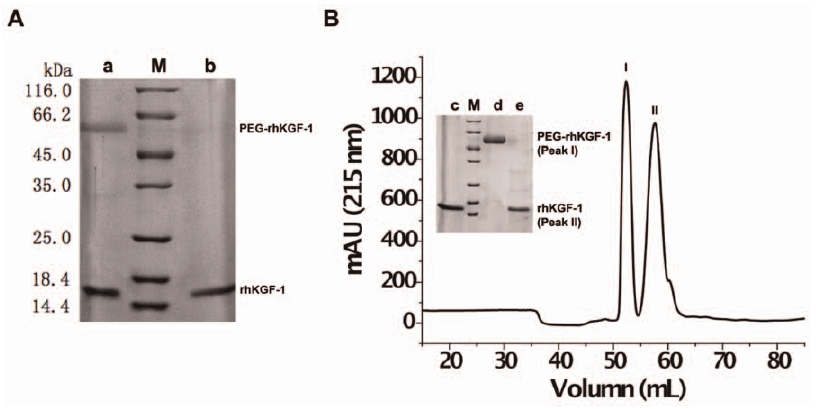
Figure 2. SDS-PAGE analysis and elution profile of solid-phase PEGylation reaction mixture. Panel A. SDS-PAGE analysis of solid-phase PEGylated rhKGF-1. Lane M, molecular weight standards; lane a, solid-phase PEGylation products obtained at PEG-to-protein ratio of 10/1 and reaction time of 8 h; lane b, non-PEGylated rhKGF-1. Panel B. Elution profile of PEGylation reaction mixture on a SP Sepharose Fast Flow column. The Insert panel shows SDS-PAGE analysis of the fractions collected from SP Sepharose